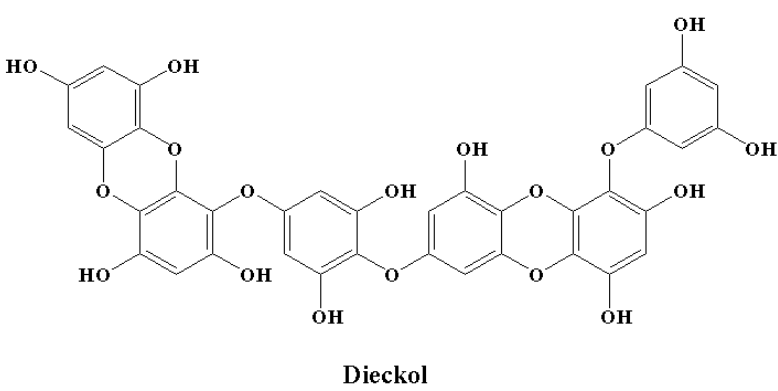
Figure 8. Chemical structure of a marine polyphenol with anti-inflammatory potential.